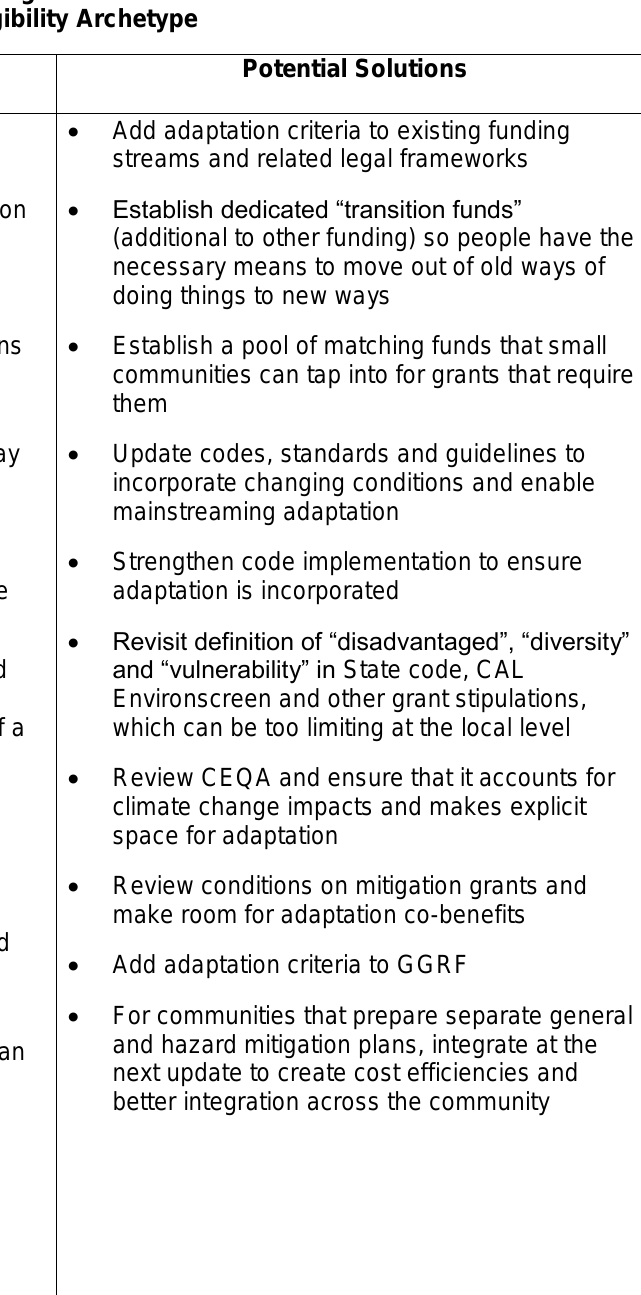
Table A2.15: Characteristics, Underlying Causes and Potential Solutions to